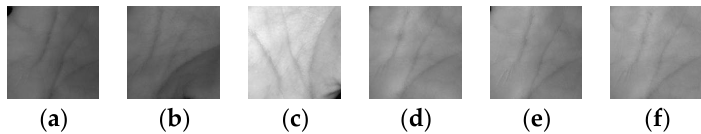
Figure 5. Variation of illumination and palm posture in the CASIA database . ( a – f ) respectively show the variation of illumination and palm posture among the palmprint ROI images.